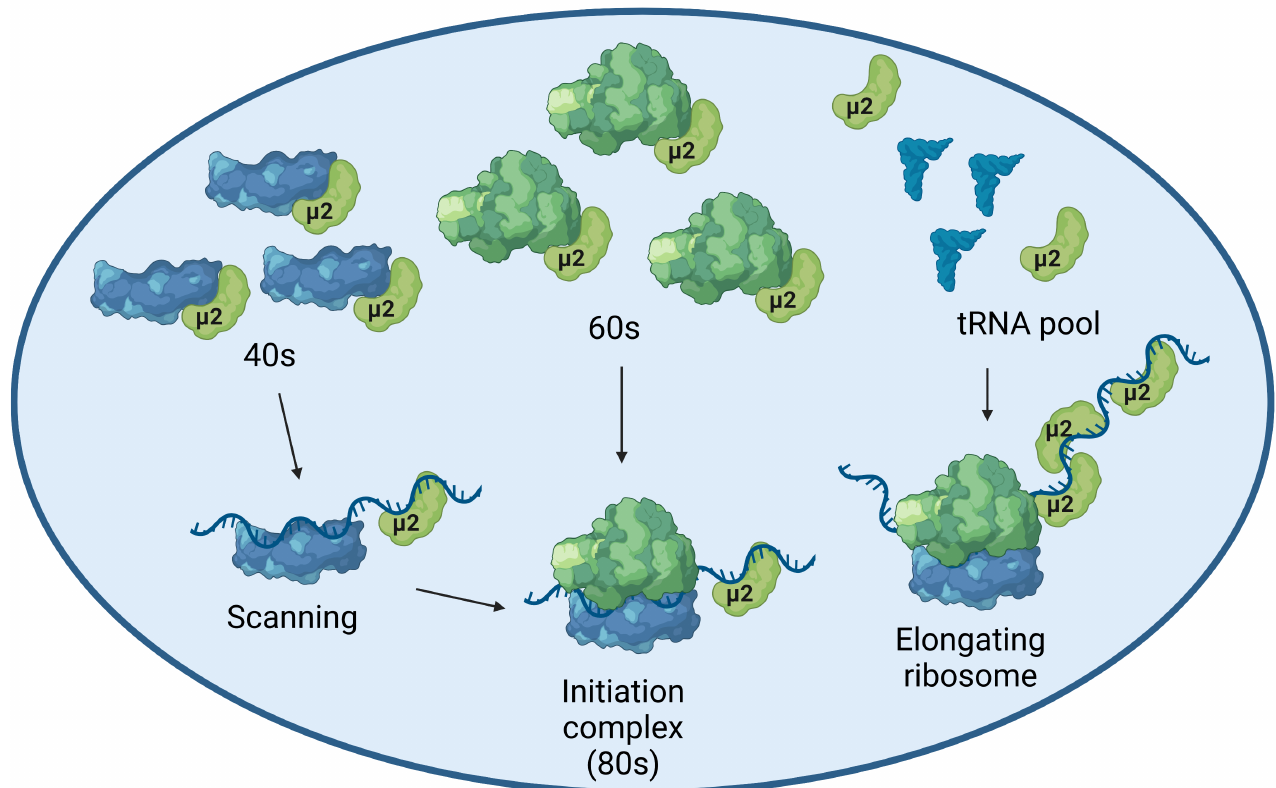
Figure 6. Model depicting how µ 2 might exert its effect on translation. µ 2 might interact directly with the small subunit of the ribosome, or the large subunit, as recently suggested by IP-MS data of the interactome of µ 2 [16]. Moreover, µ 2 is bound to cellular mRNA, which might affect the initiation steps of translation. Since µ 2 elutes with all the light polysomal fractions (40S, 60S and 80S), all these possibilities are supported by our experimental data. Furthermore, the elongating ribosome is bound to encounter µ 2 attached to the mRNA, which might alter the stability of the elongating ribosome. Finally, µ 2 might interact with numerous tRNA synthetase, which could affect the pool of loaded tRNA available for the elongating ribosome. Created with